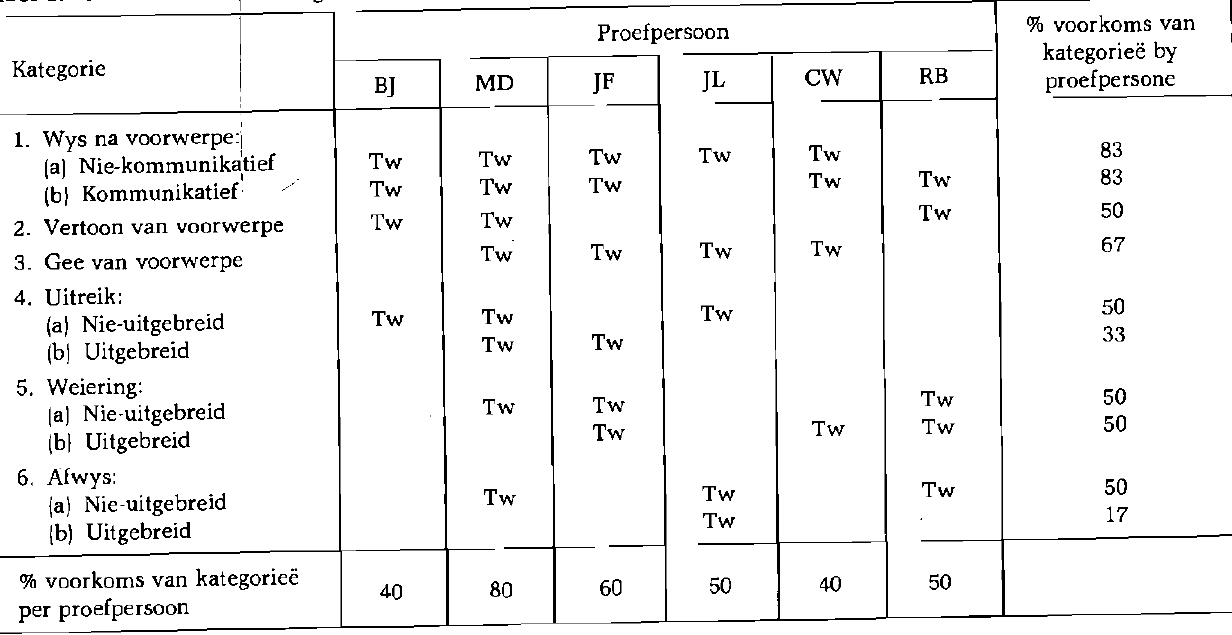
Tabel 8 verskaf die resultate van elke proefpersoon in terme van die teenwoordigheid en toepaslike gebruik van die kate- goriee van kommunikatiewe gebare volgens Bates (1977). Uit Proefpersoon